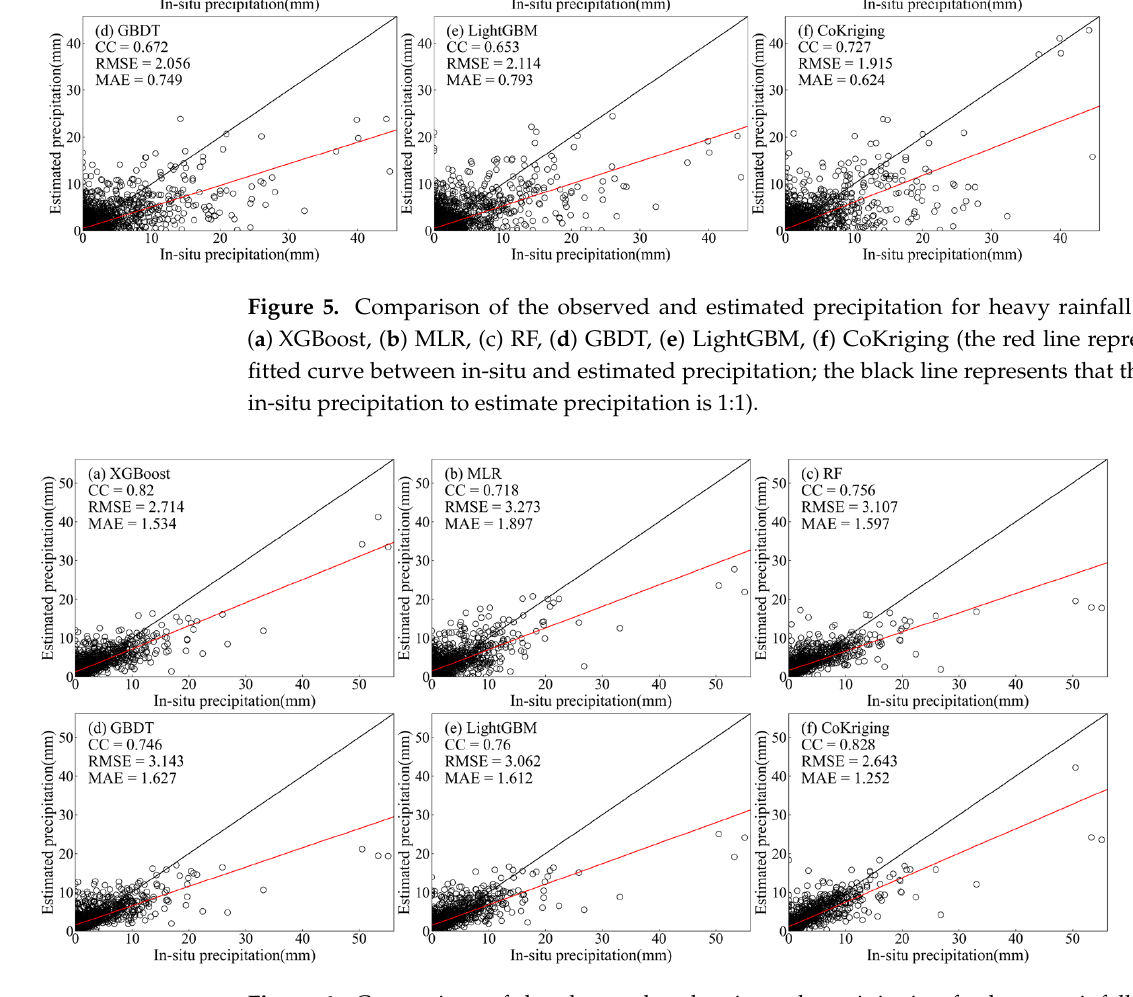
Figure 6. Comparison of the observed and estimated precipitation for heavy rainfall event IV : (a) XGBoost, (b) MLR, (c) RF, (d) GBDT, (e) LightGBM, (f) CoKriging (the red line represents the fitted curve between in-situ and estimated precipitation; the black line represents that the ratio of in-situ precipitation to estimate precipitation is 1:1).